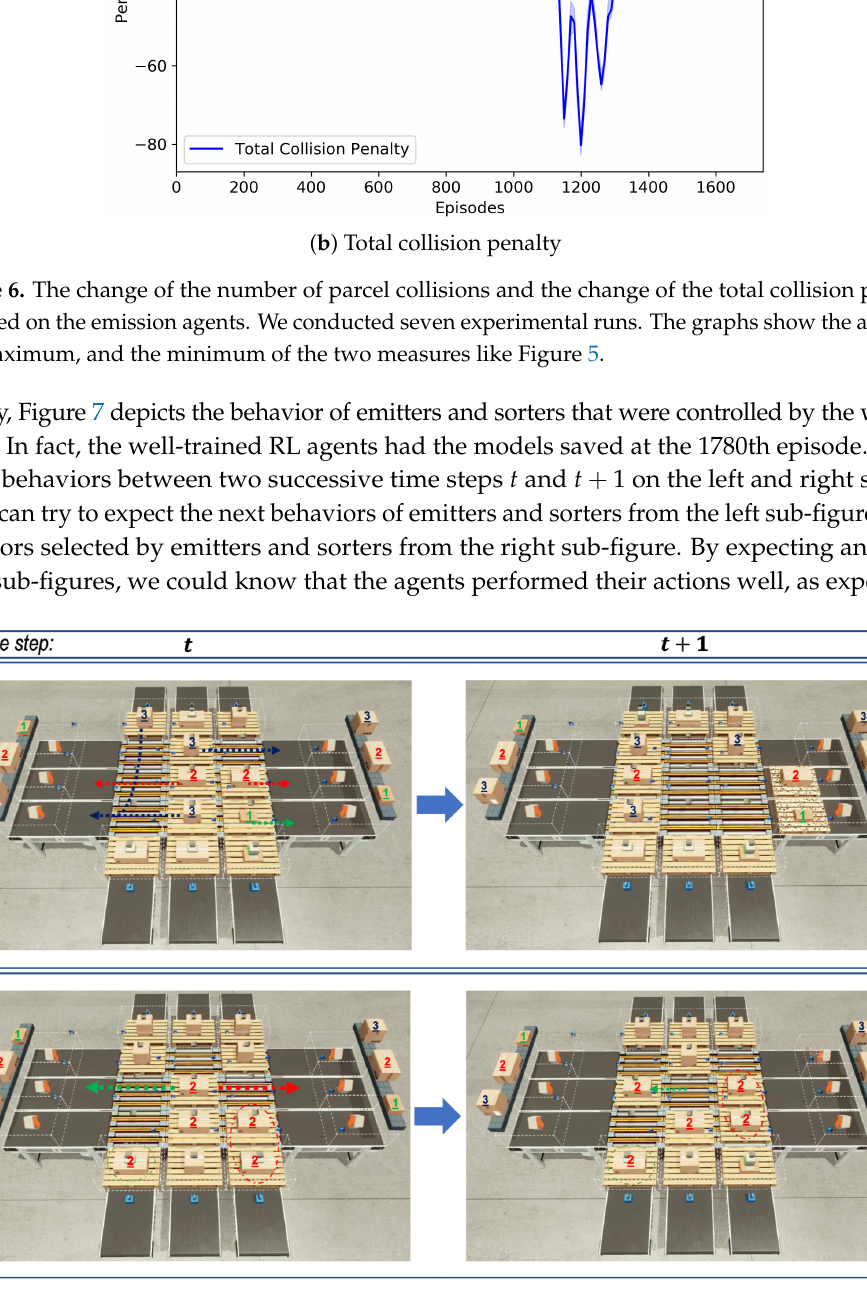
Figure 7. The graph above shows simulated screen captures of the three-grid sortation system controlled by the saved models leading to the emergent behaviors of the agents. In the first sequence of two images at the top, routing and emission agents seemed to consider the location of the parcels placed on different agents and increased throughput with unobtrusive behavior. In the second sequence of two images at the bottom, there were many parcels of the same type on the routing and emission agents, and there were just two removers for the type of parcels. In such a situation, agents seemed to perform routing so that there was less